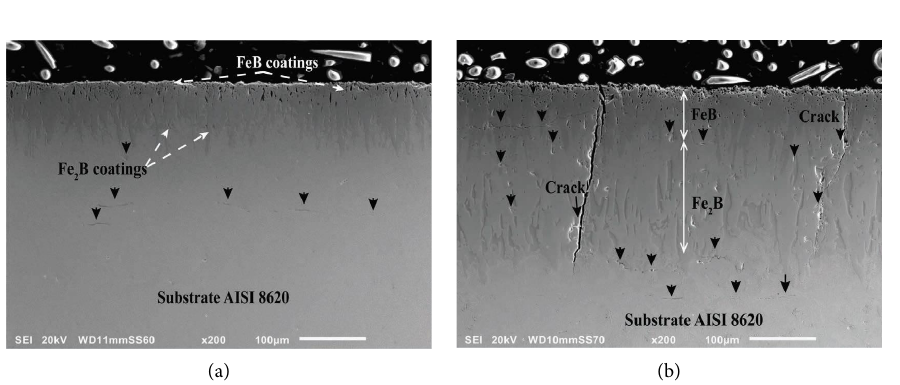
Figure 5: SEM micrographs on 8620 steel borided for 6h under charging hydrogen: (a) 1173K and (b) 1273K.